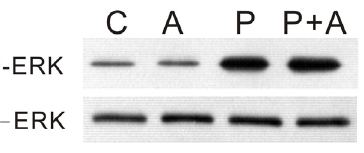
Figure 9. Effects of AICAR on PTTH-stimulated ERK phosphor- ylation. C, Glands incubated in control medium; P, glands incubated in medium containing PTTH only; A, glands incubated in medium containing 1 mM AICAR only; P + A, glands incubated in medium containing both PTTH and AICAR. Results shown are representative of three independent experiments.